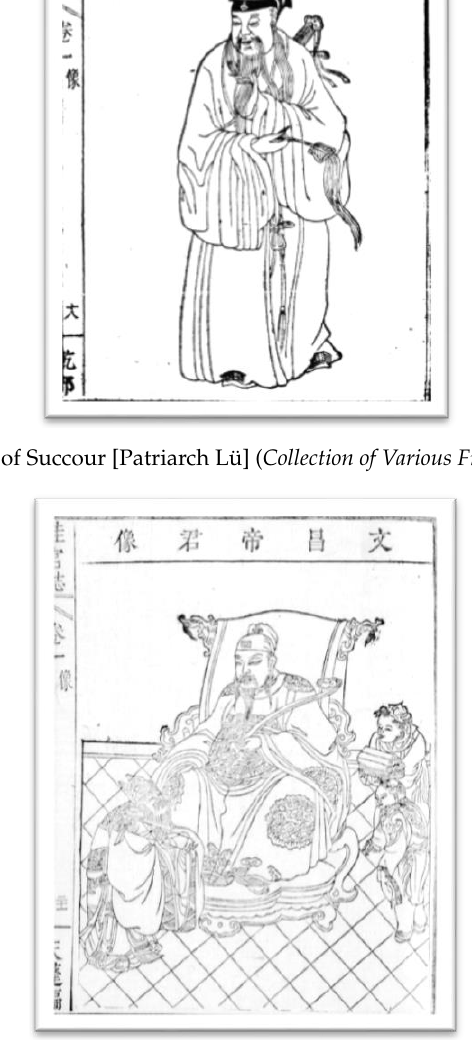
Figure 8. Thearch of Literature [Wenchang] ( Record of The Cassia Palace [KGJ] 1881).